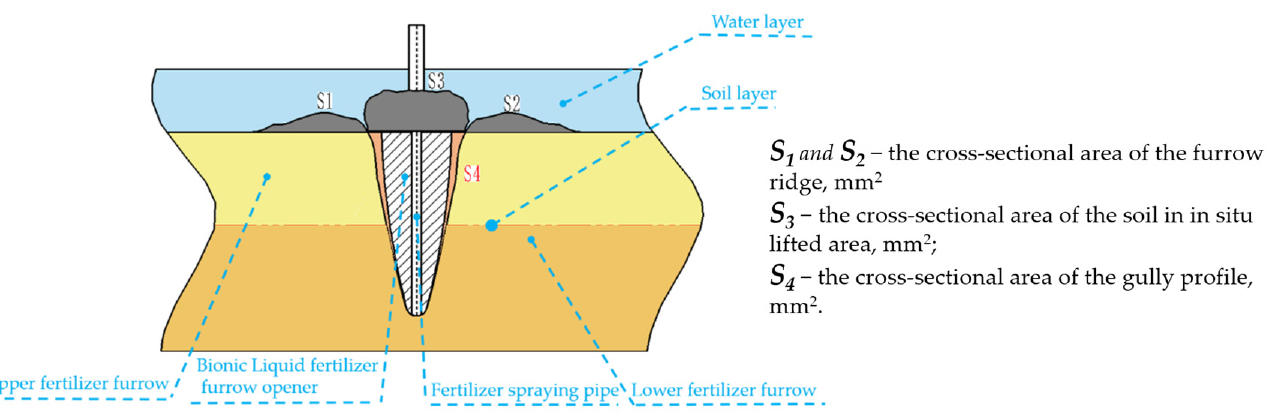
Figure 10. Schematic diagram of soil disturbance.